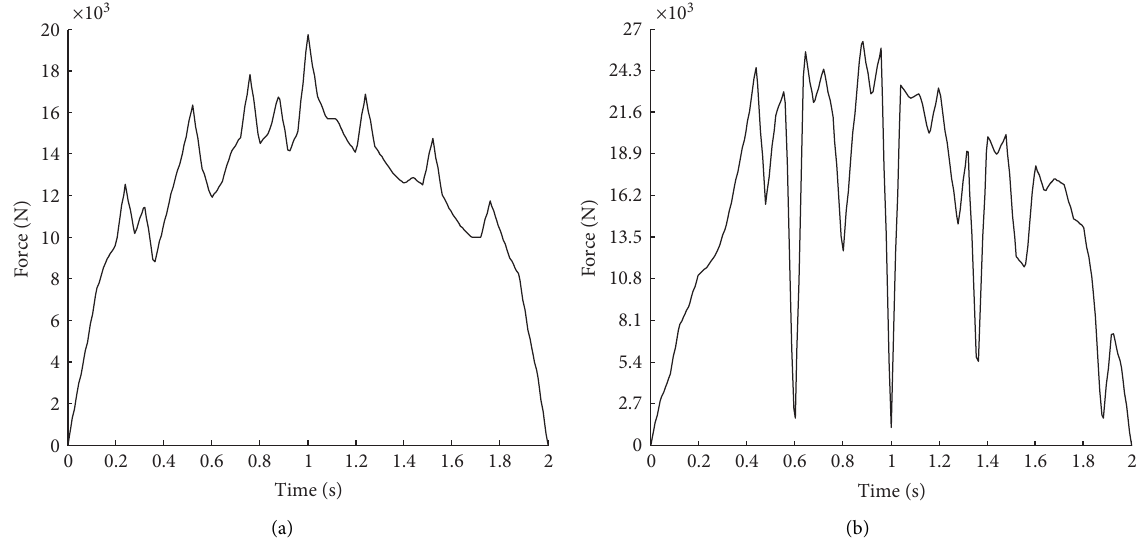
Figure 20: Force of cutting disc for each scheme. (a) With picks impact. (b) Without picks impact.